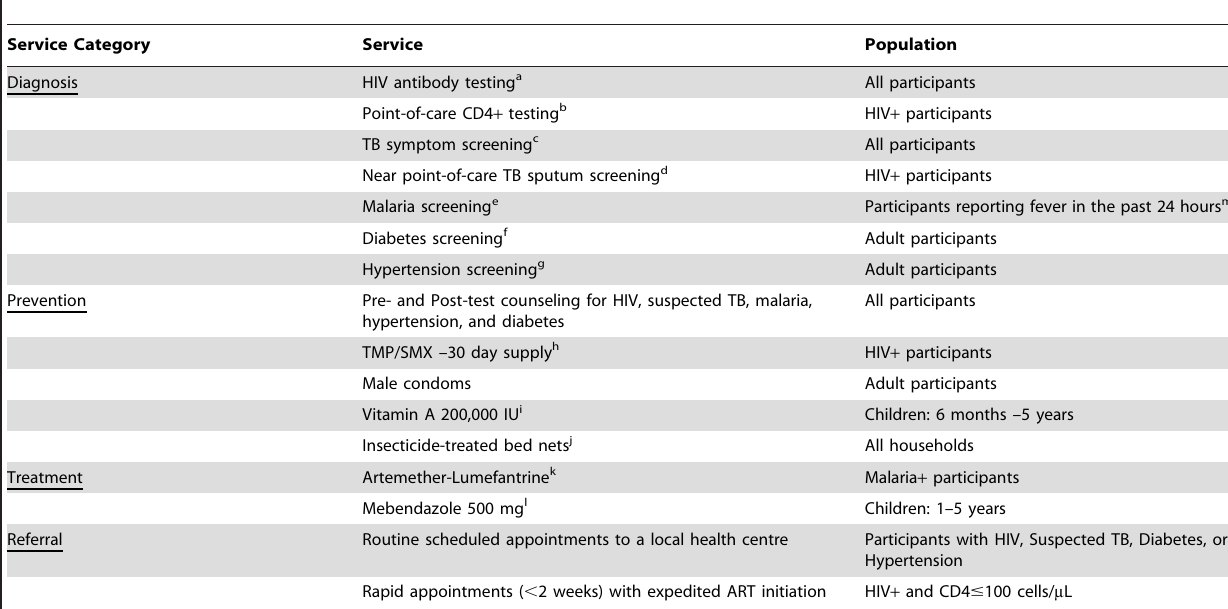
Table 1. High Throughput Kakyerere Parish Community Health Campaign Services.